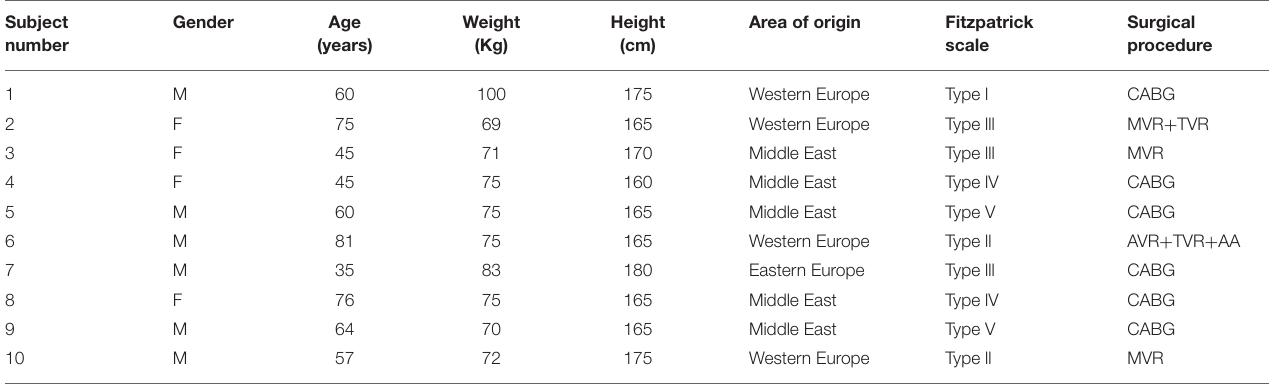
TABLE 1 | Patient characteristics.